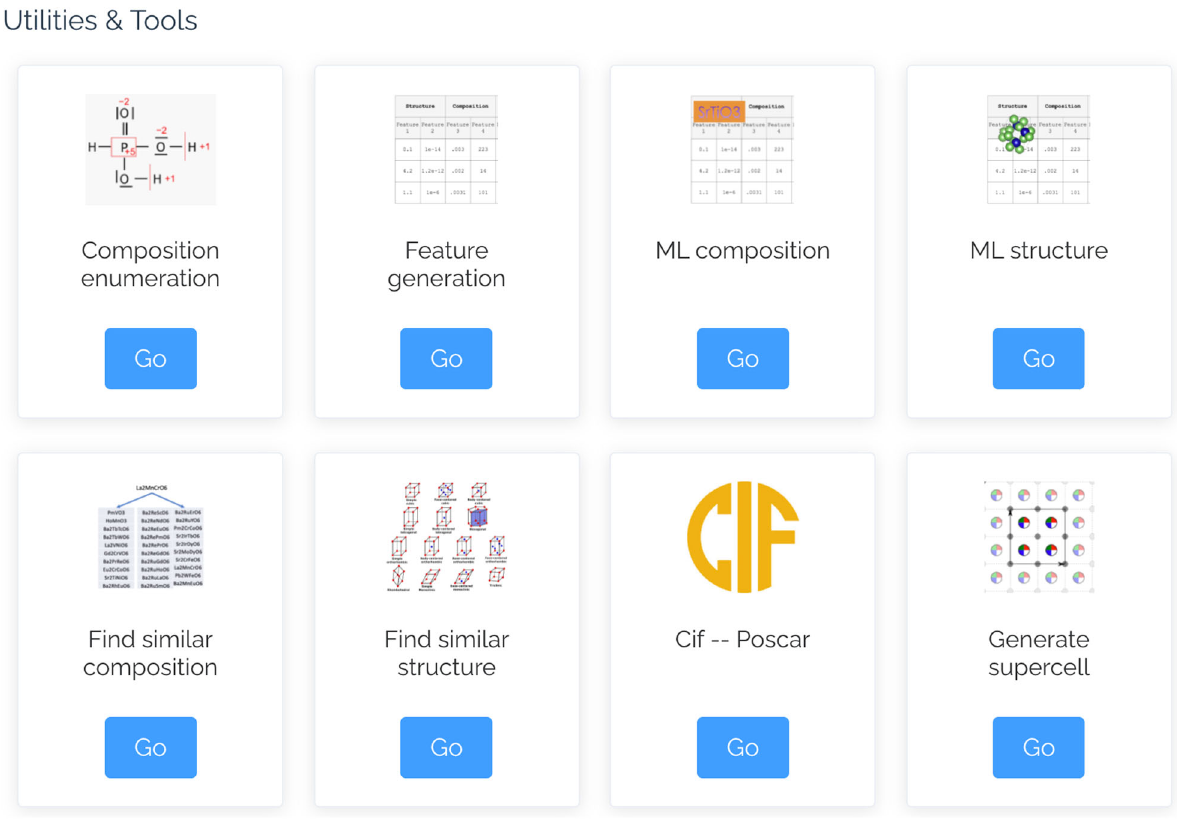
Fig. 4 Utility tool web